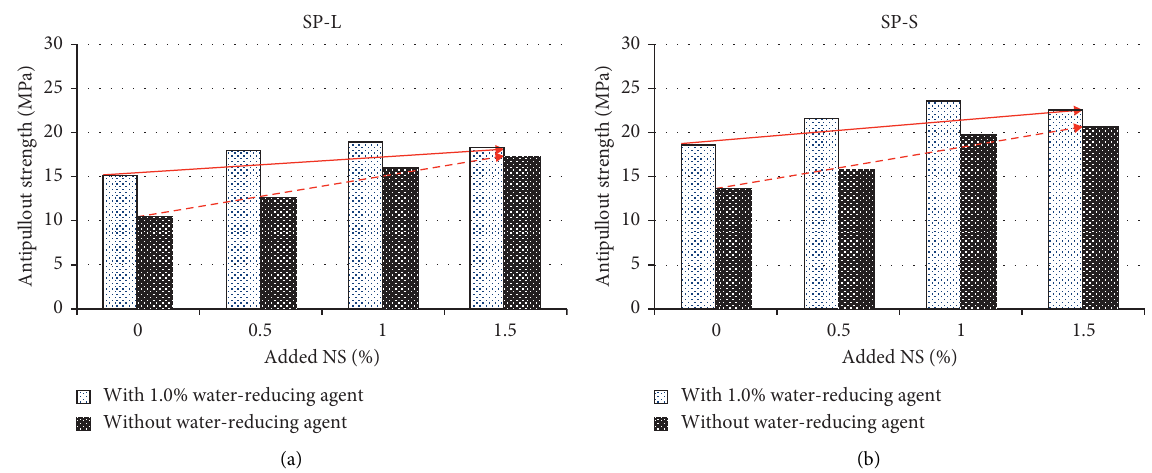
Figure 6: Variation of the antipullout strength with added NS with or without the water-reducing agent: (a) larger specimen size; (b) smaller specimen size.